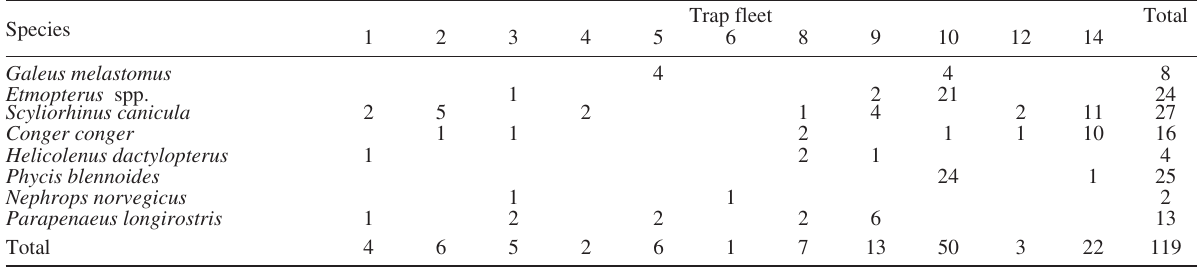
Table 2. – By-catch composition. Values in the table correspond to the total number of individuals of each by-catch species on each trap line. Species Galeus melastomus